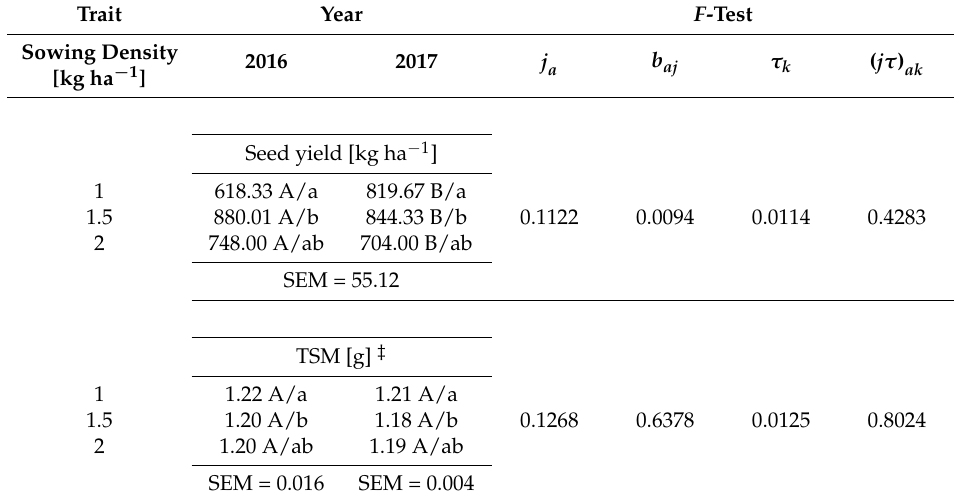
Table 4. Estimated seed yield (kg ha − 1 ) and thousand seed mass (TSM) [g] of chia (Genotype G8) based on model (2) cultivated at three different sowing densities (1, 1.5, 2 kg ha − 1 ) at Ihinger Hof in 2016 and 2017, along with standard error of the mean (SEM) and F -tests ( n = 3, α = 0.05). Trait F